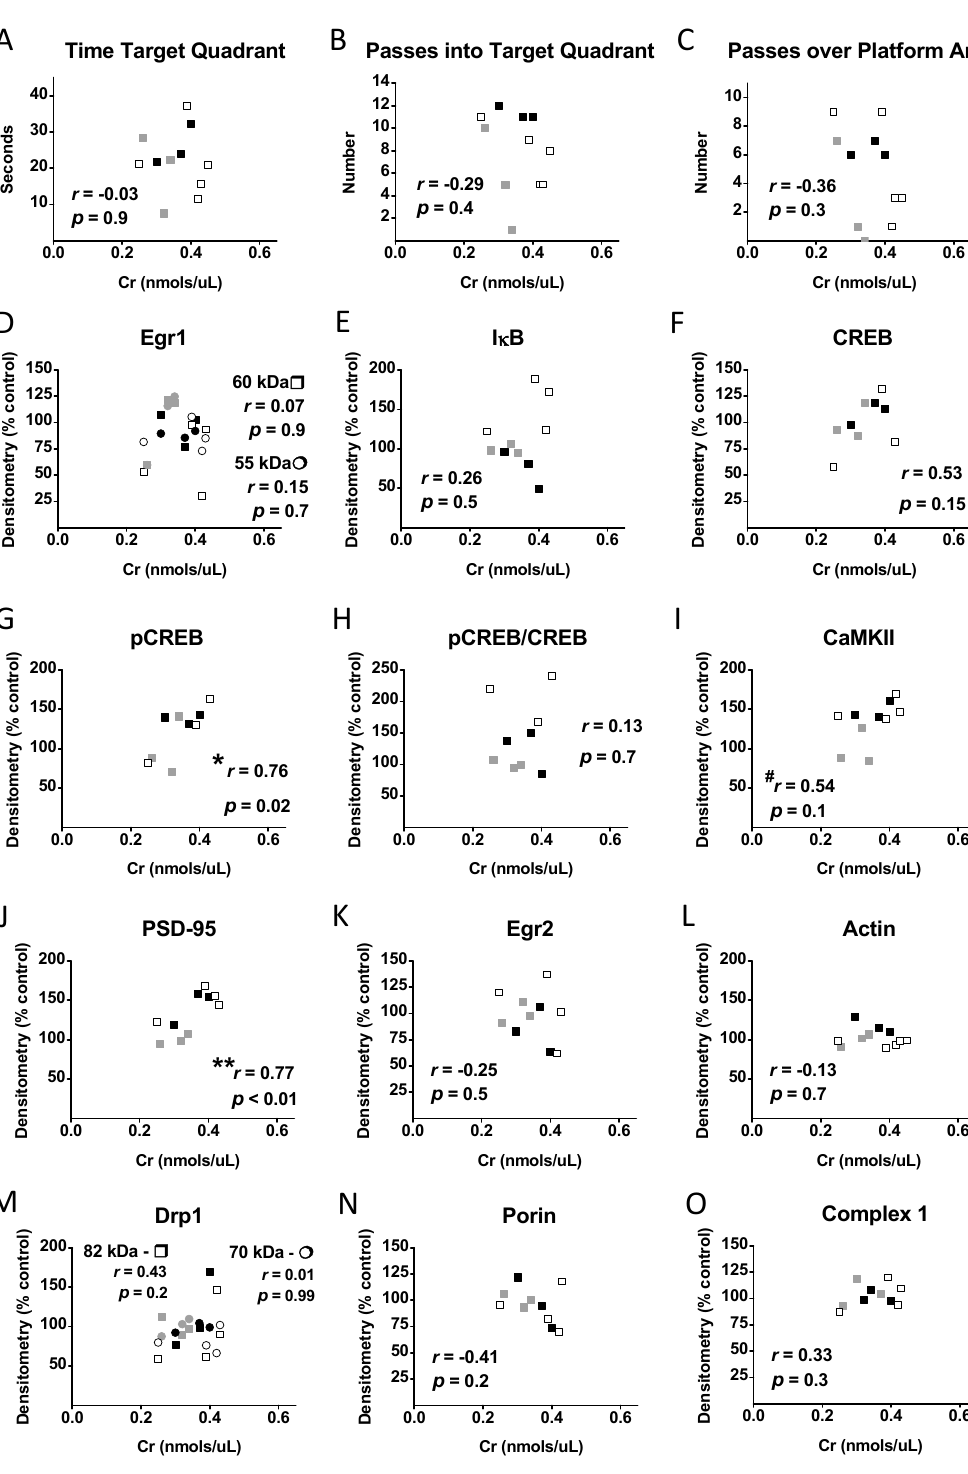
Figure 12. Correlational analyses between Cr, memory, and protein levels. Pearson correlation coefficients between hippocampal Cr levels and ( A – C ) MWM probe trial parameters and relative normalized densitometry values from Western blot experiments measuring ( D – H ) transcription factor, ( I – L ) plasticity-related, and ( M – O ) mitochondrial proteins in control-fed male (black squares) and female (gray squares) 3xTg mice, as well as female 3xTg mice on a Cr-supplemented (white squares) diet. Note: n = 3–5, # p = 0.1, * p < 0.05; ** p < 0.01.